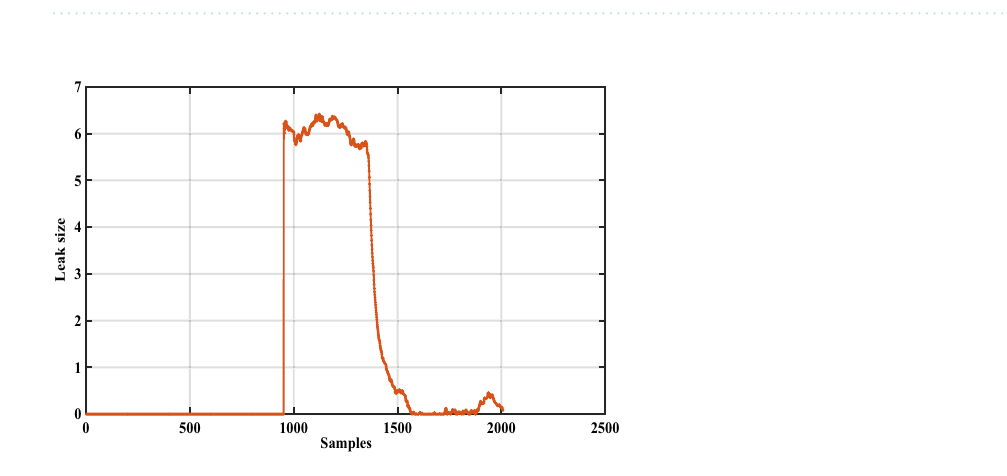
Figure 13. The leak size of the oil pipeline.